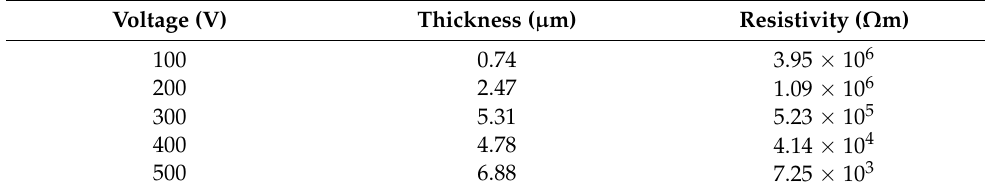
Table 2. Thickness and resistivity of the PEO coating by CV operation.